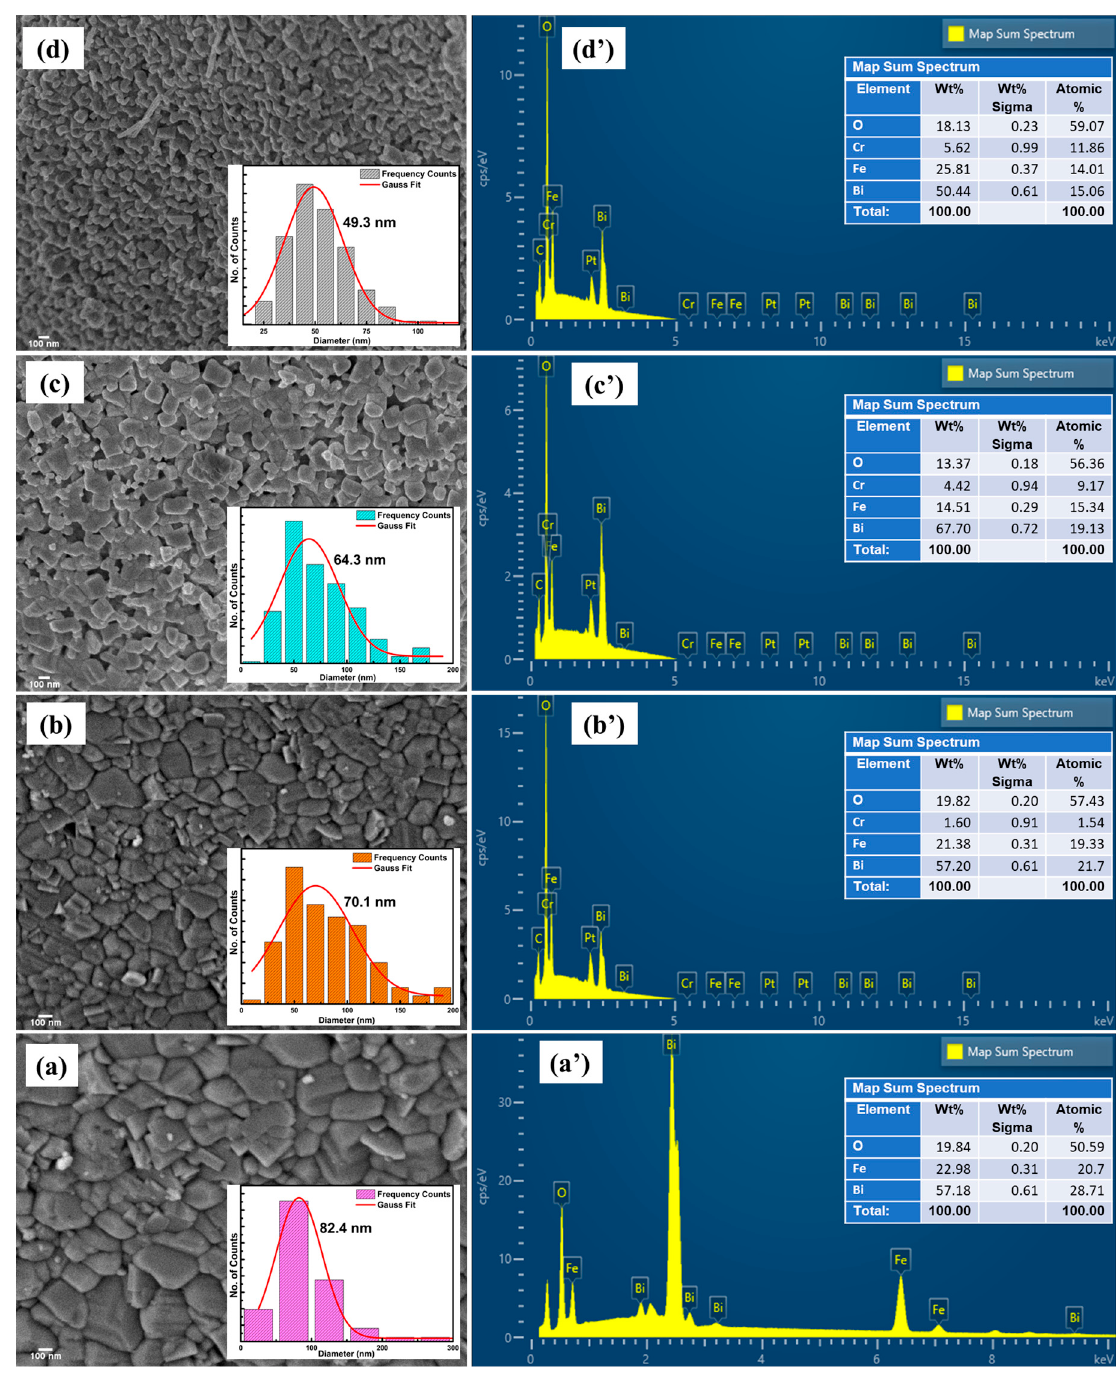
Figure 3. ( a – d ) HR-FESEM micrographs of BiFe 1 − x Cr x O 3 (0 ≤ x ≤ 10) nanoparticles; insets show